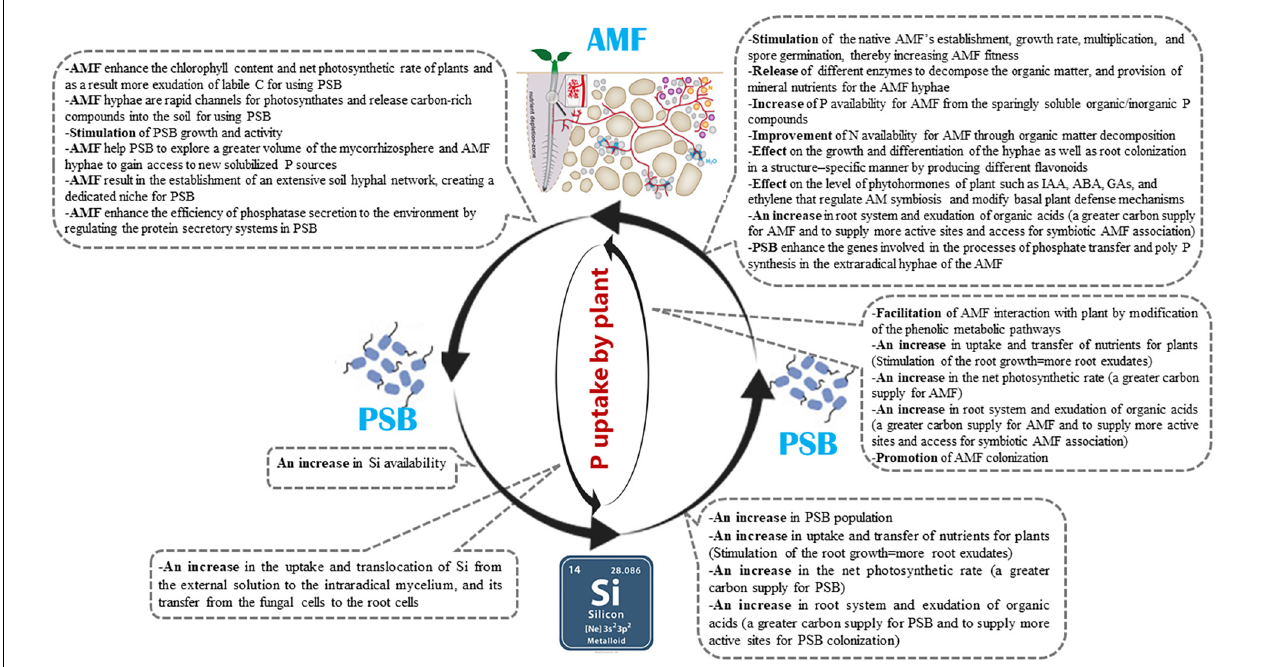
FIGURE 4 | Synergistic effects of among arbuscular mycorrhizal fungi (AMF), phosphate-solubilizing bacterium (PSB), and silicon (Si) on P Availability and its uptake by